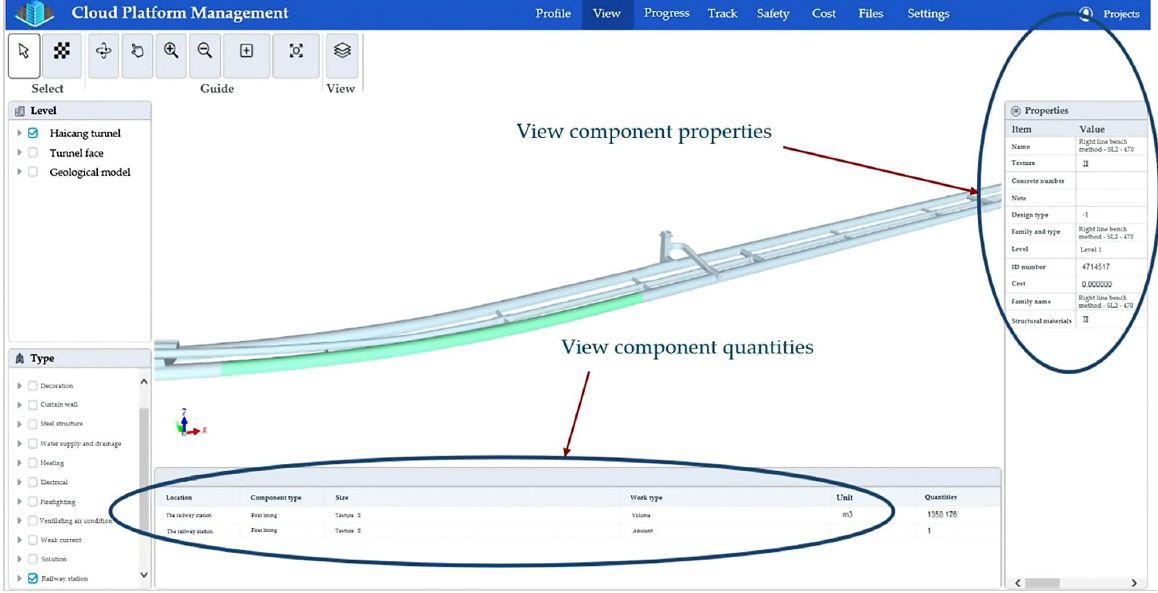
Figure 14. Online browse model to view detailed properties such as component quantity